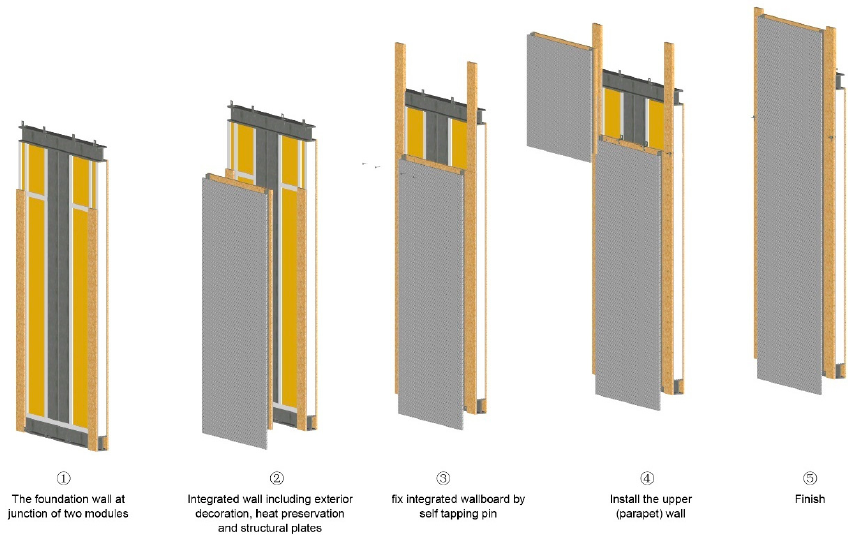
Figure 4. Installation of exterior wall panel with integrated finish, waterproofing, thermal insulation, and structure. and